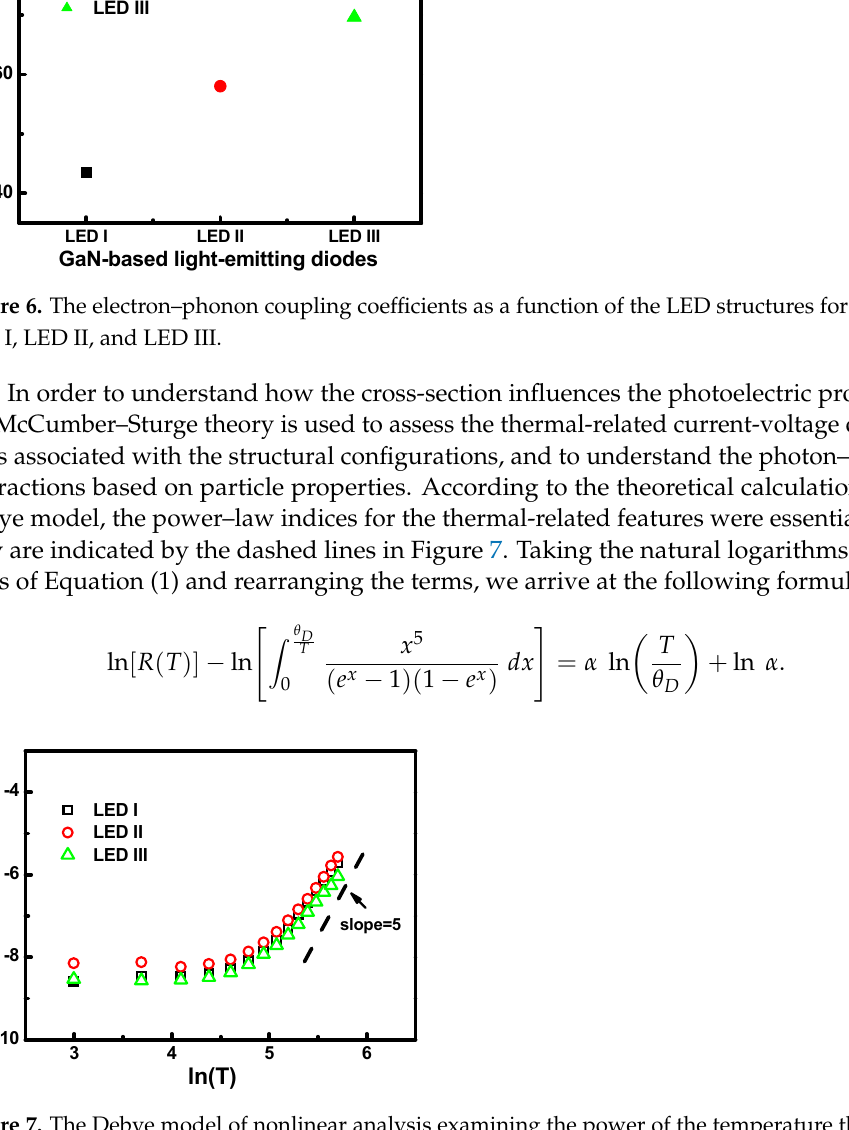
Figure 7. The Debye model of nonlinear analysis examining the power of the temperature through a log–log plot for associated samples.